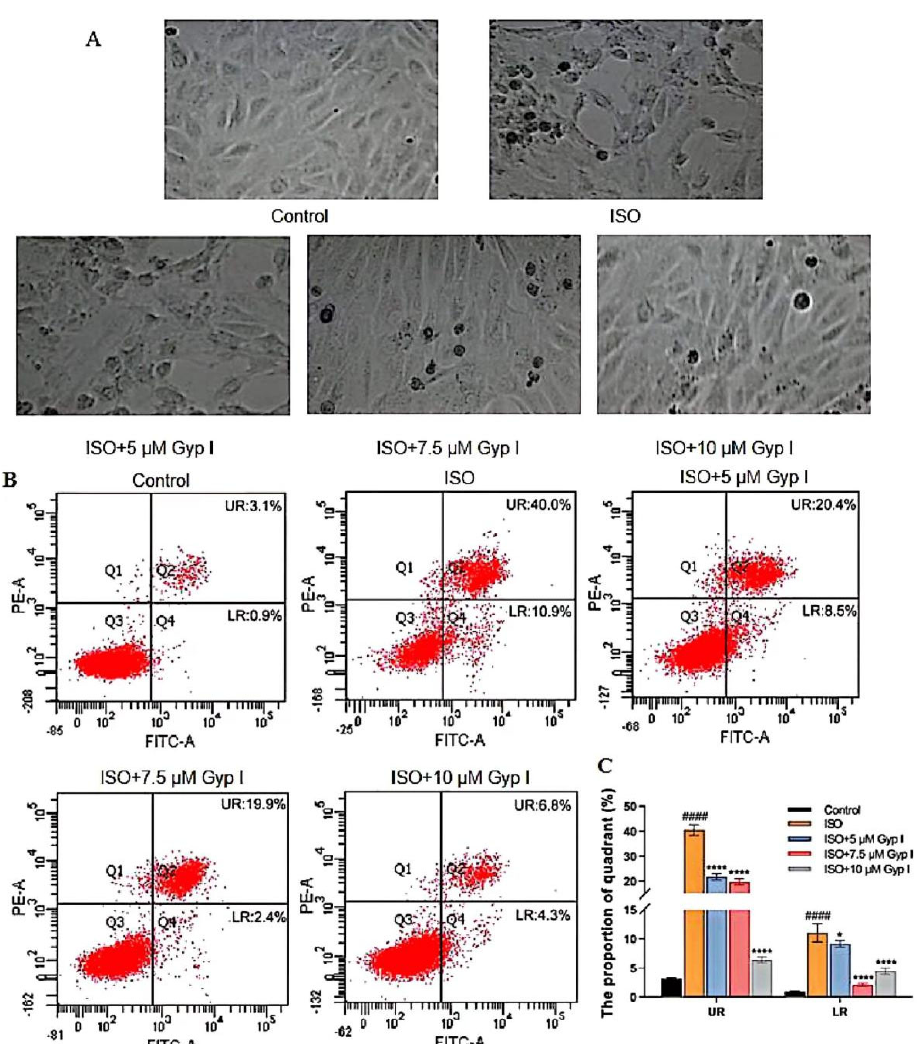
Figure 2. Gyp I protects ISO ‐ induced apoptosis in H9c2 cells: ( A ) Morphology of Gyp I on ISO ‐ induced apoptosis in H9c2 cells (40×). ( B ) Analysis of apoptosis using the Annexin/Propidium lodide (PI) assay of H9c2 cells in the Control group, ISO group, and Gyp I (5, 7.5, and 10 μ M) groups. ( C ) Histogram of Gyp I on the degree of early and late apoptosis of H9c2 cells induced by ISO (200 μ M). Results are presented as mean ± SD of three independent experiments using one ‐ way ANOVA followed by Tukey’s multiple ‐ comparison test (####: p < 0.0001 compared with Control group; *: p < 0.05, ****: p < 0.0001 compared with ISO group).